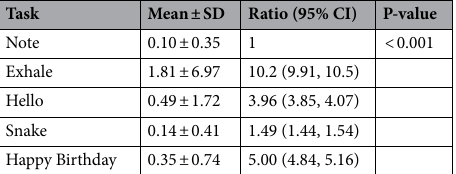
Table 3. Comparison of mean droplet density across all tasks when wearing a face